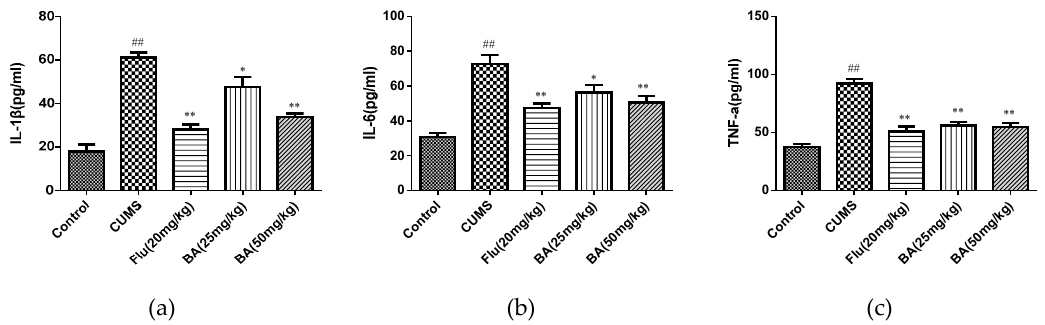
Figure 4. Effects of BA on proinflammatory cytokines ( a ) IL-1 β , ( b ) IL-6, ( c ) TNF- α in serum. Data were expressed as mean ± SEM ( n = 6). ## p < 0.01 vs. the control; ** p < 0.01, * p < 0.05 vs. the chronic unpredictable mild stress (CUMS) group.